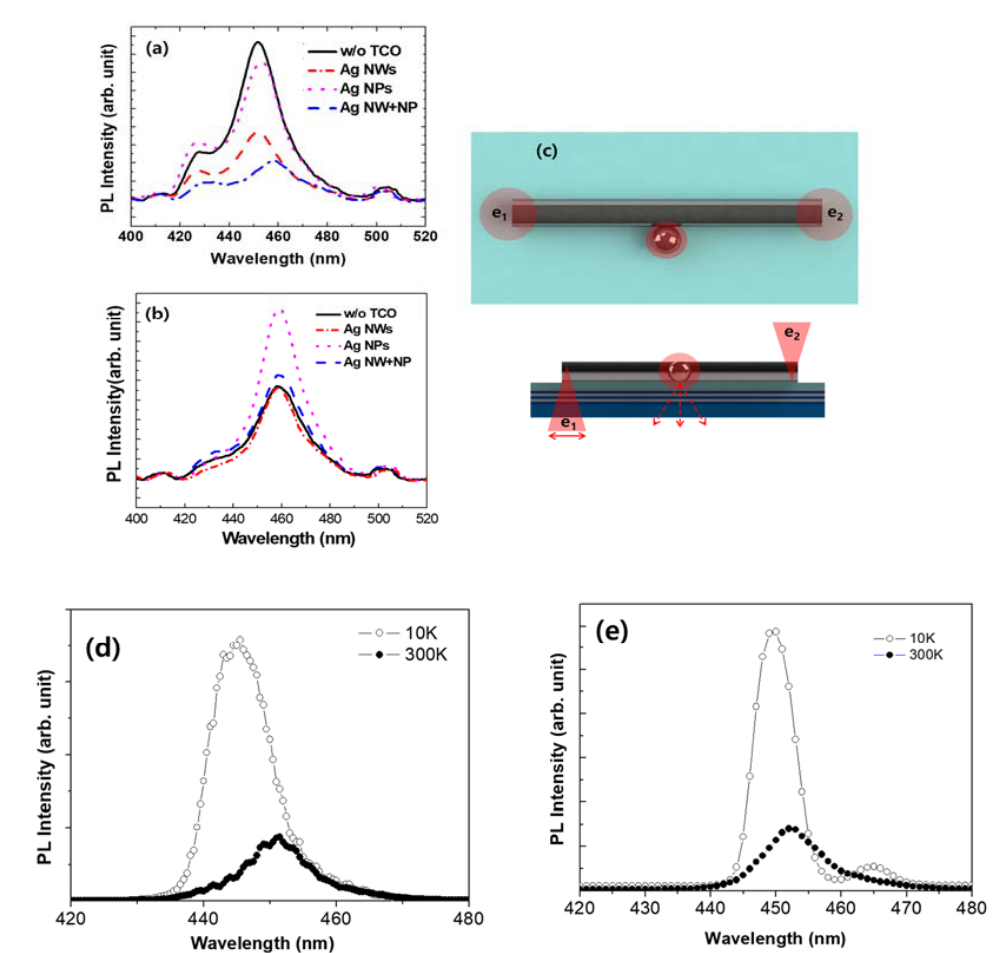
Figure 3. PL spectra of GaN LEDs with ( a ) 120 nm thick and ( b ) 45 nm thick p-GaN layer without TCE and with Ag NW, Ag NP, and Ag NW/NP TCEs and ( c ) schematic diagram of light extraction by plasmon leakage radiation and PL spectra with GaN LED (45 nm thick p-GaN layer) ( d ) without TCE and ( e ) with Ag NW/NP TCE at 10 K and 300 K.